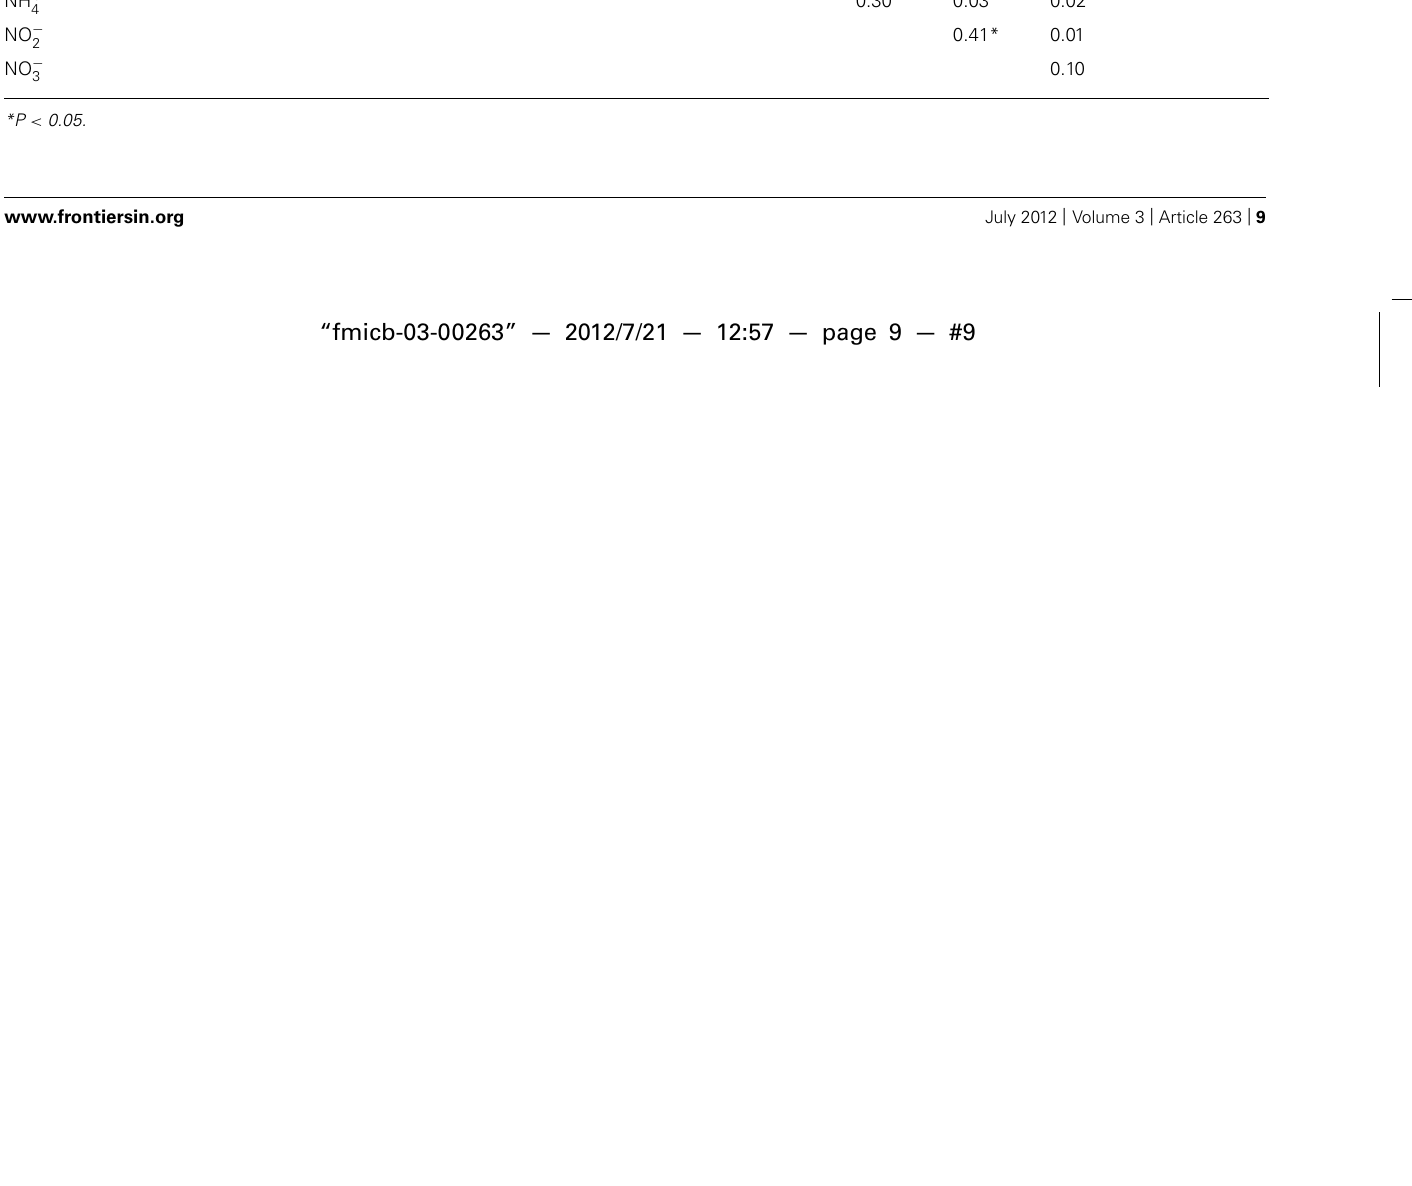
oxidation rates averaged across 4